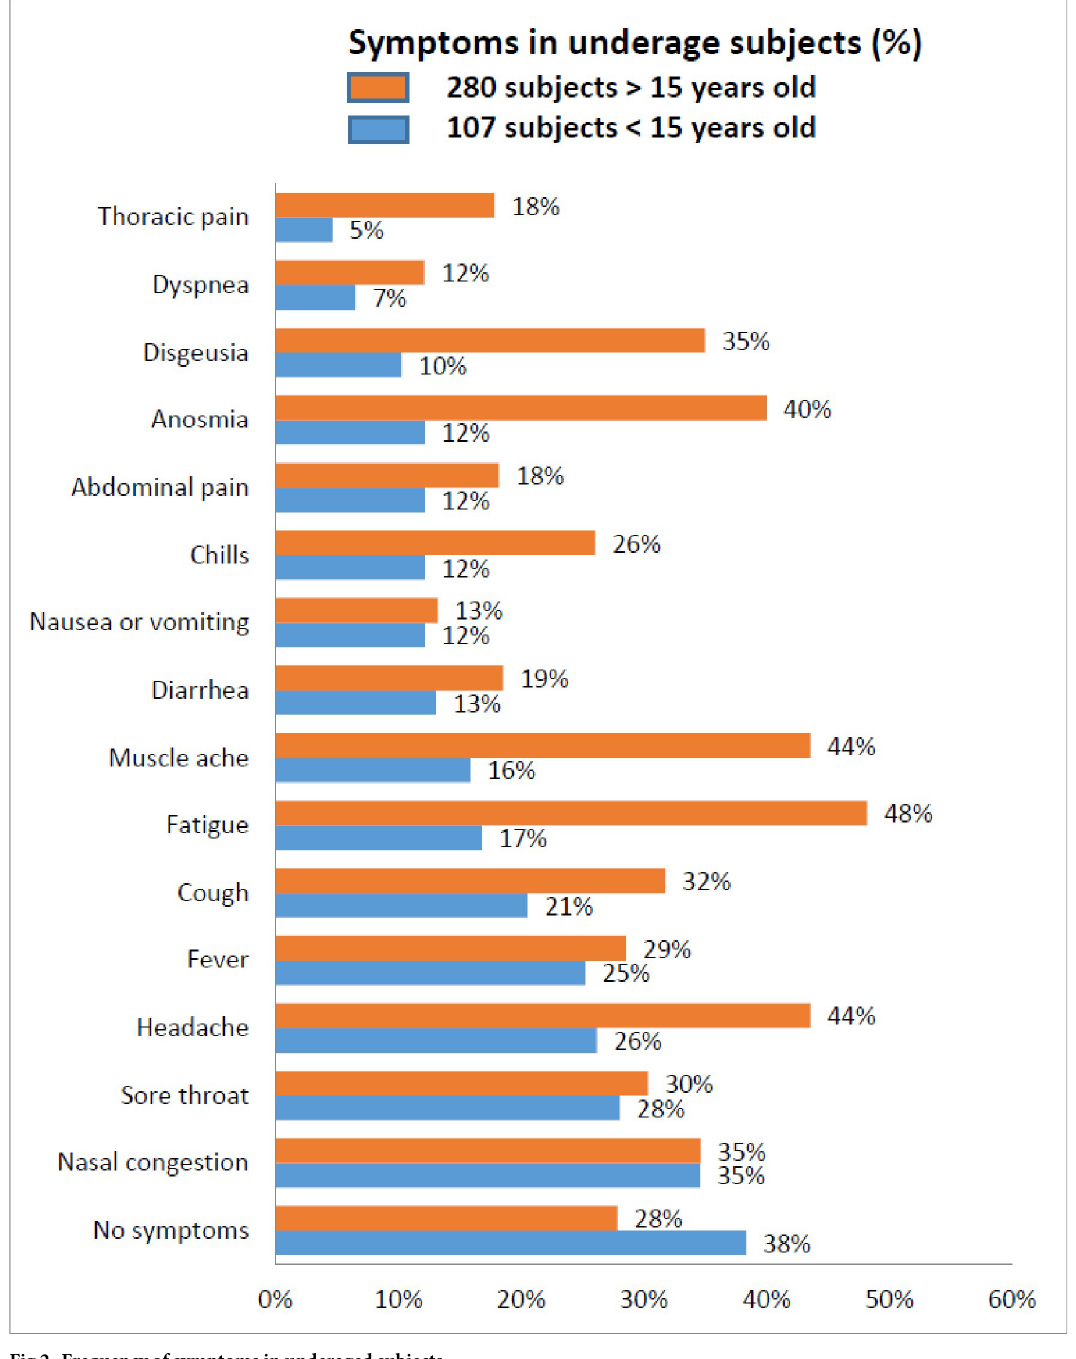
Differences in symptoms between minors under 15 years old and older than15 years with positive result to SARS-CoV-2, are shown in Fig 5. Comparison between the seroprevalence of SARS-CoV-2 for each symptom in the two age groups shows that there are only statistically significant differences in seroprevalence for fever and no symptoms.